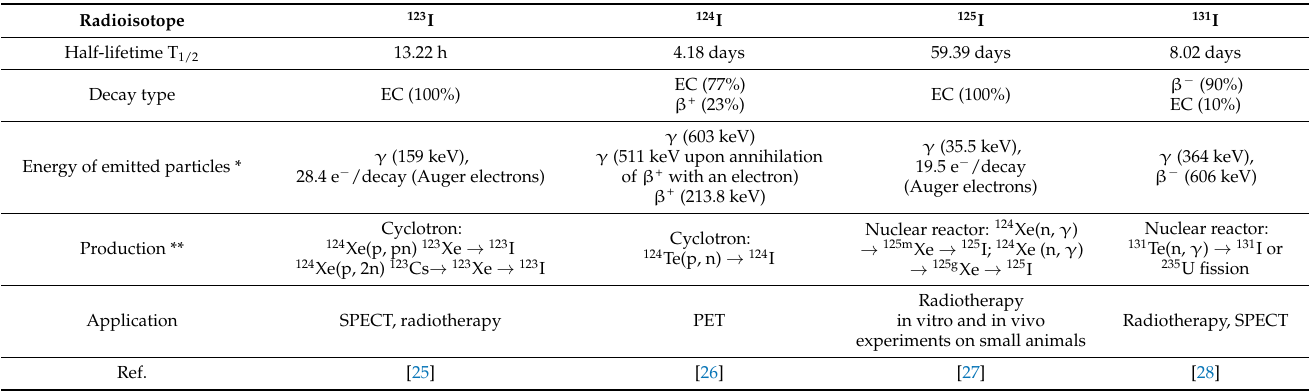
Table 2. Iodine isotopes used in nuclear